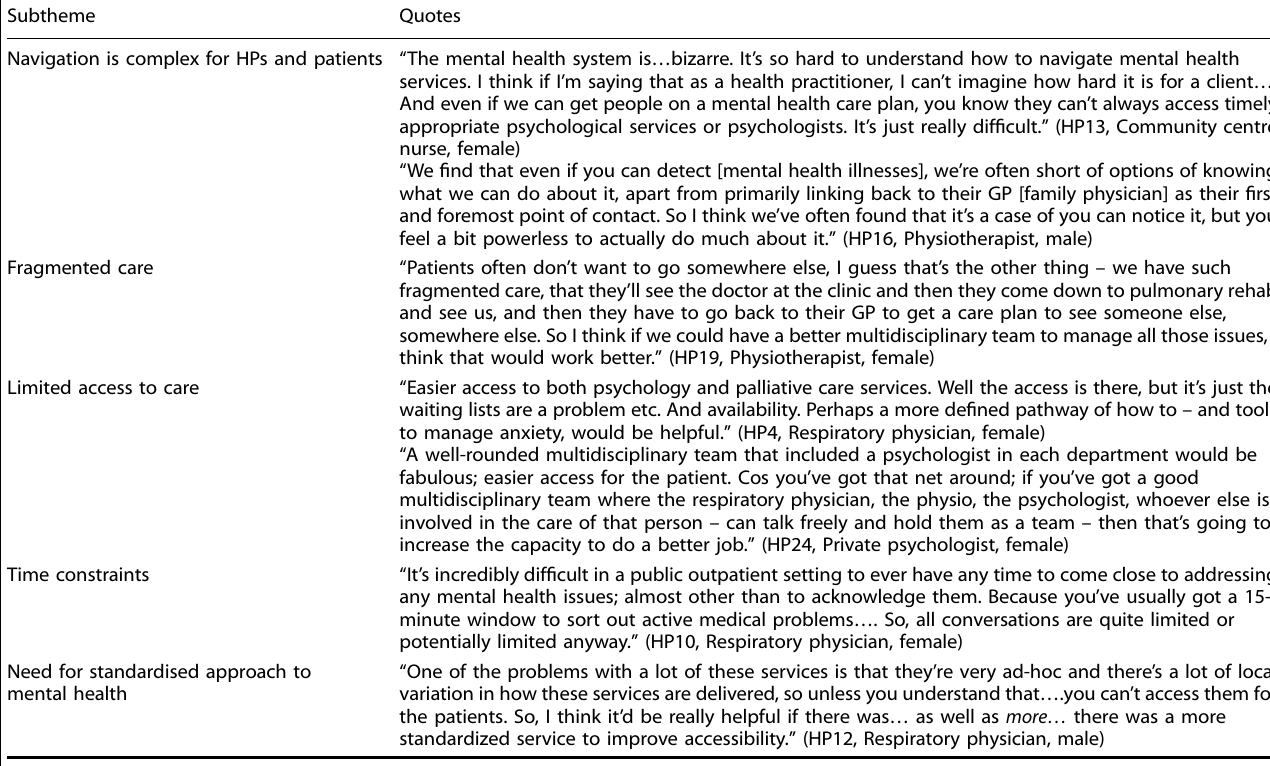
Table 6. Complexity navigating the health system. Subtheme